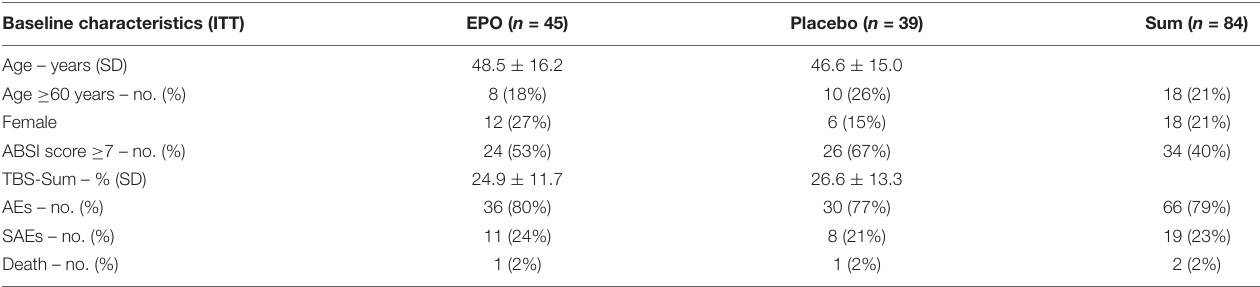
TABLE 2 | Baseline characteristics of ITT